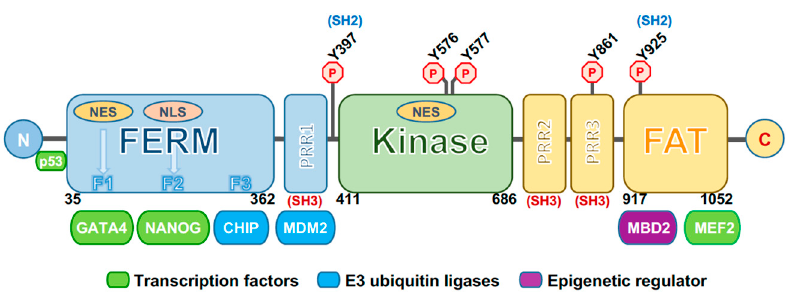
Figure 1. Schematic representation of focal adhesion kinase (FAK). The three main domains of FAK are depicted: The N-terminal 4.1, ezrin, radixin, moesin homology domain (FERM) (in blue), central kinase domain (in green), and focal-adhesion targeting (FAT) domain (in yellow). Domain boundaries are shown. F1, F2, and F3 represent the three lobes of the FERM domain and the regions for binding with transcription factors (such as GATA4 and NANOG) and E3 ubiquitin ligase factors (such as CHIP). Other binding sites are those for MDM2 (E3 ubiquitin ligase), MBD2 (methyl-CpG binding domain protein 2, an epigenetic factor) and MEF2 (transcription factor). Outside the FERM domain the p53-binding site is shown. A nuclear localization sequence (NLS) is located at the F2 FERM lobe, while two nuclear export sequences (NES) are at the F1 FERM lobe and in the kinase domain. PRR1, 2, and 3 represent proline-rich regions (i.e., two polyproline (PxxP) motifs) that interact with the Src homology SH3 domains of several proteins, including Src. Several phosphorylation sites are depicted, among which include Y397, the autophosphorylation site, and Y925, both binding sites for Src. N: N-terminus. C: C-terminus.